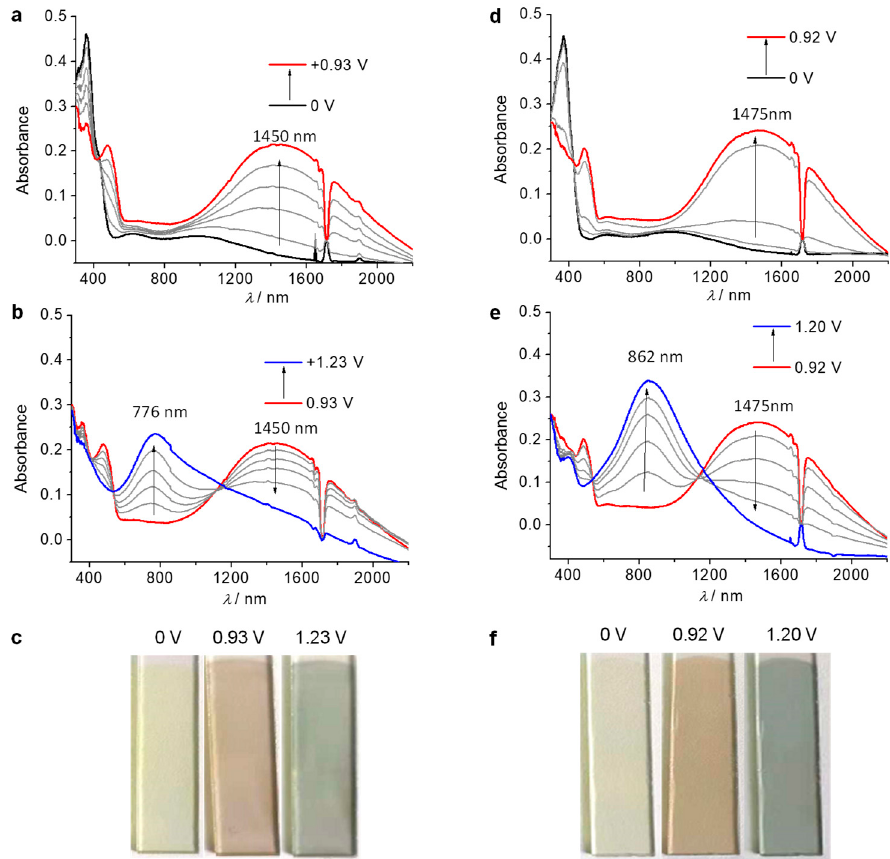
Figure 4. ( a , b , d , e ) Absorption spectral changes and ( c , f ) pictures at different applied potentials of ( a – c ) P1 /ITO and ( d – f ) P2 /ITO films recorded during spectroelectrochemical measurements. The applied potentials are referenced versus Ag/AgCl.